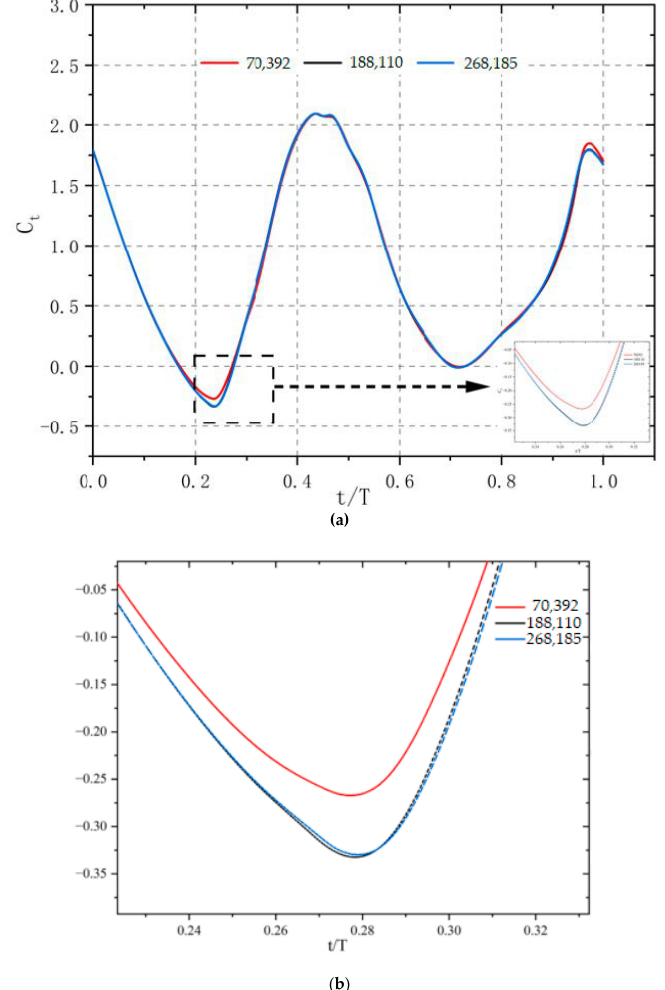
Figure 5. (a) variation of thrust coefficient in one cycle of different grids, ( b ) enlarged part of figure (a). The difference in grid quantity among the three groups is mainly due to the differ- ence in near-wall grid growth rate. Obviously, around 0.2 T, the calculated values of the